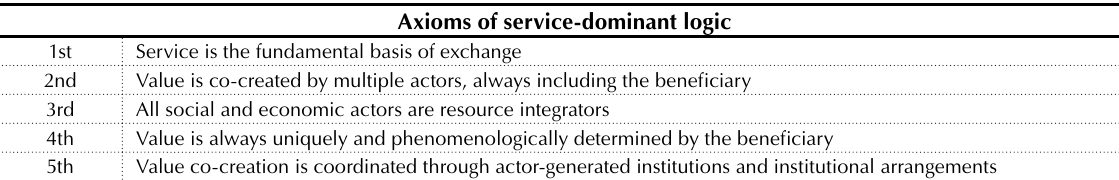
Table 1. Axioms of service-dominant